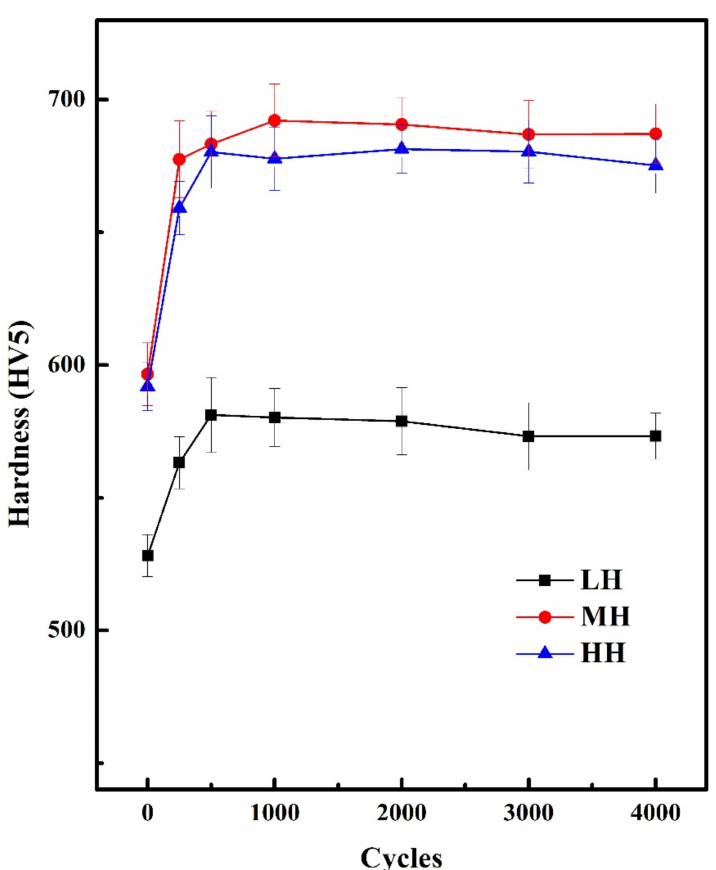
Figure 9. Microhardness after different numbers of thermal fatigue testing cycles (650 ◦ C/30 ◦ C). Curve of MH is cited from reference, adapted from ref.